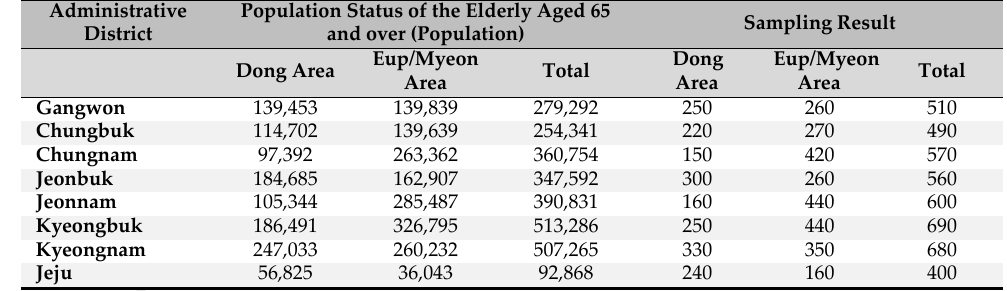
Population Status of the Elderly Aged 65 and over